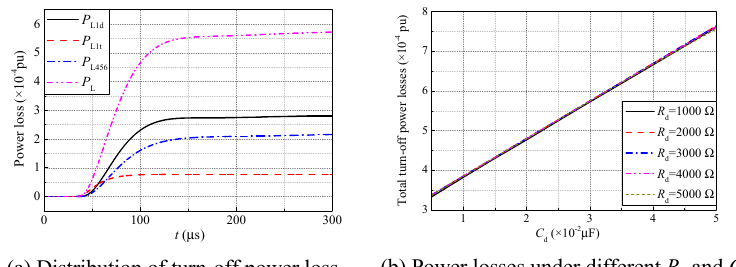
Figure 7. Characteristics of Turn-off Power Losses.